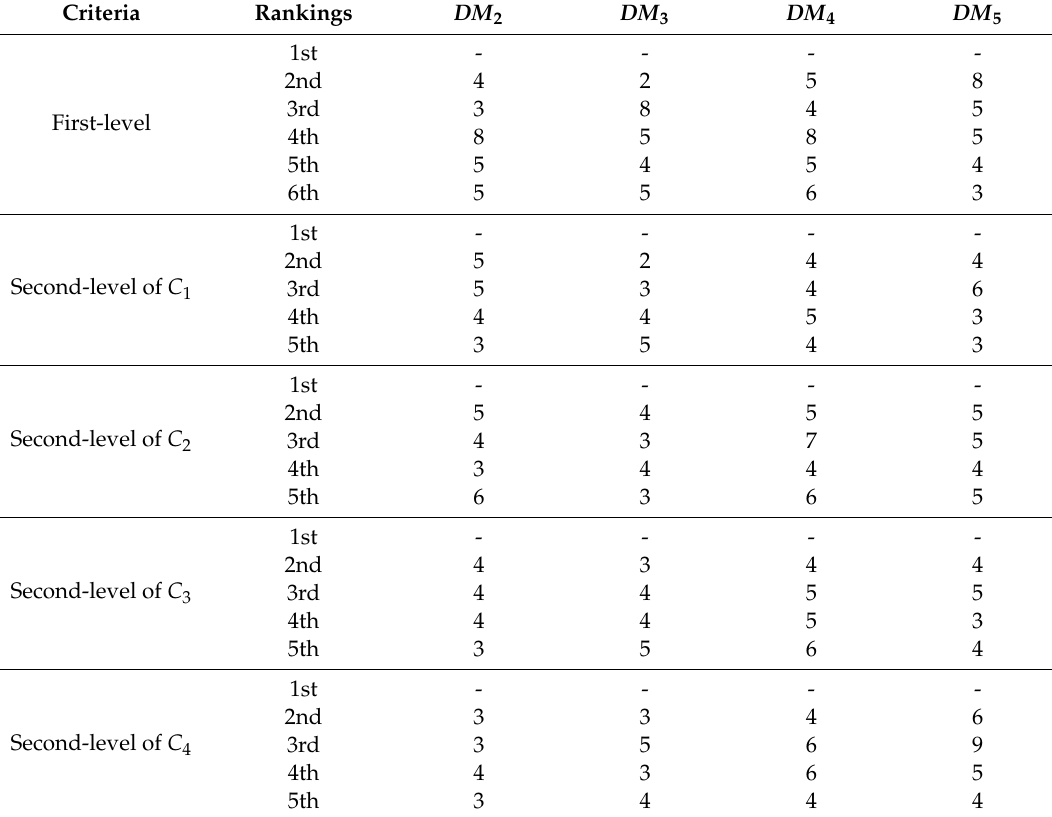
Table 2. Raw data of the